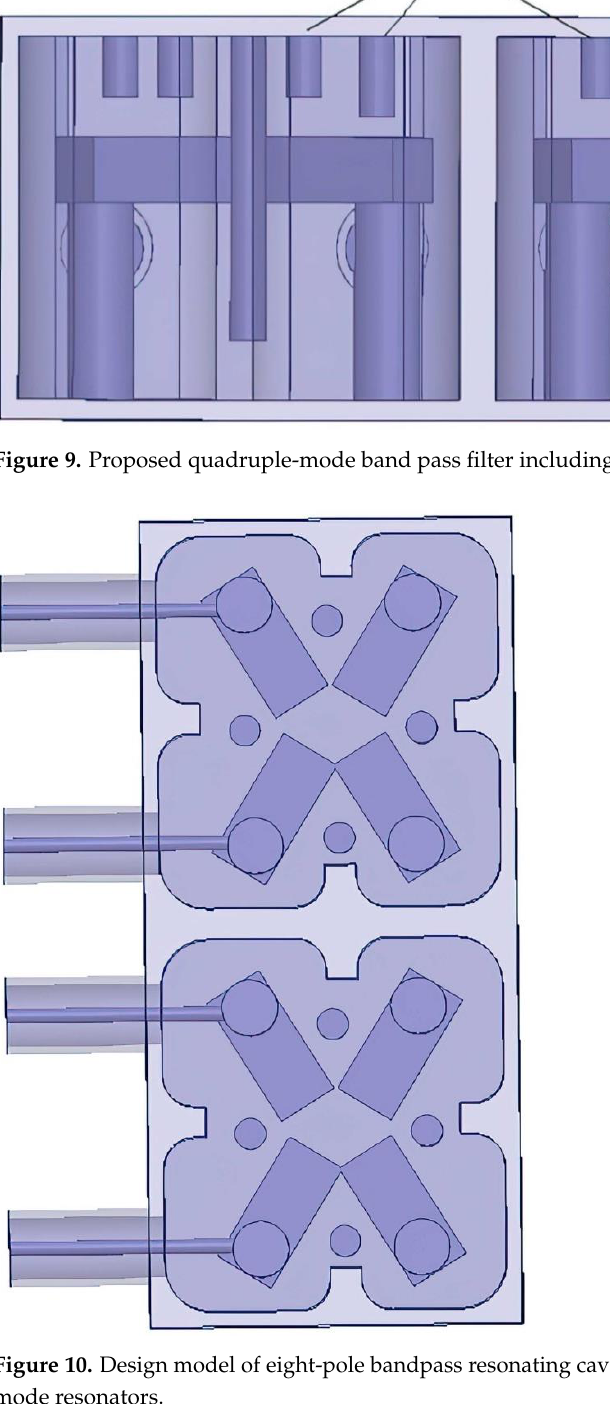
Figure 10. Design model of eight-pole bandpass resonating cavity filter by cascading two quadruple-mode resonators.